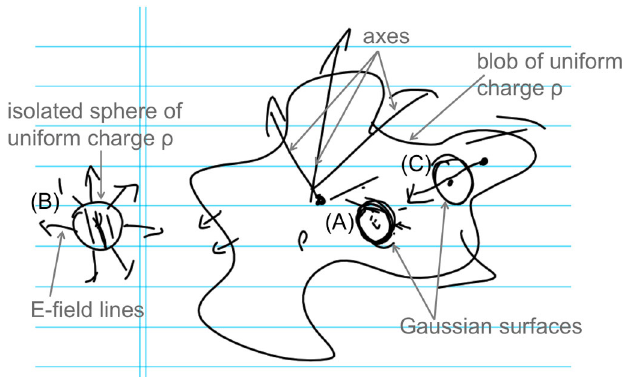
FIG. 2 (color online). Student drawing from Gauss’s law inter- view. After drawing axes and the nonuniform blob of charge, the student drew the left-hand Gaussian surface, (A), and explained as detailed in the text. The student next drew the isolated sphere of charge, (B), to help explain her point, followed by the right- hand Gaussian surface,